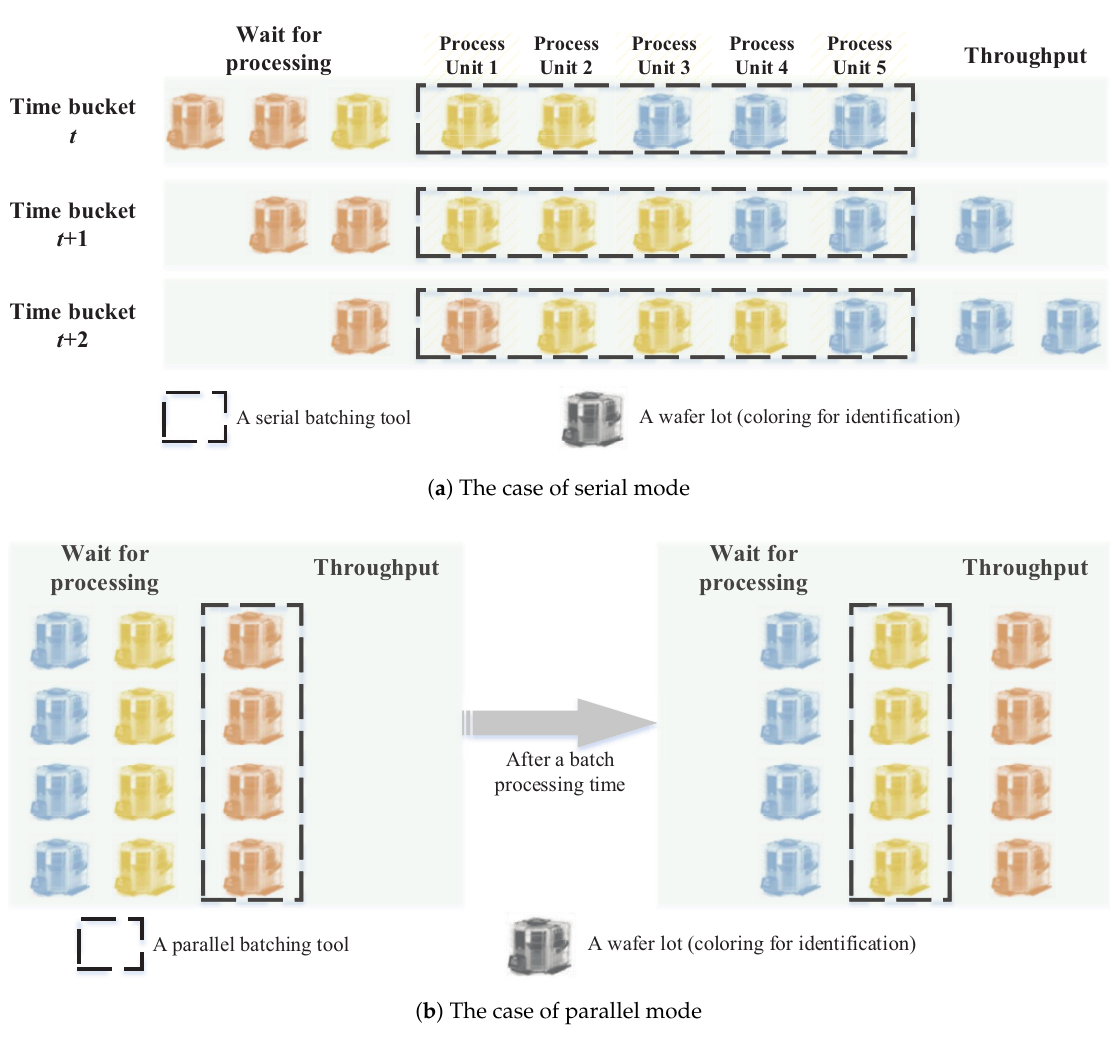
Figure 3. An illustration of batch processing between serial and parallel modes.